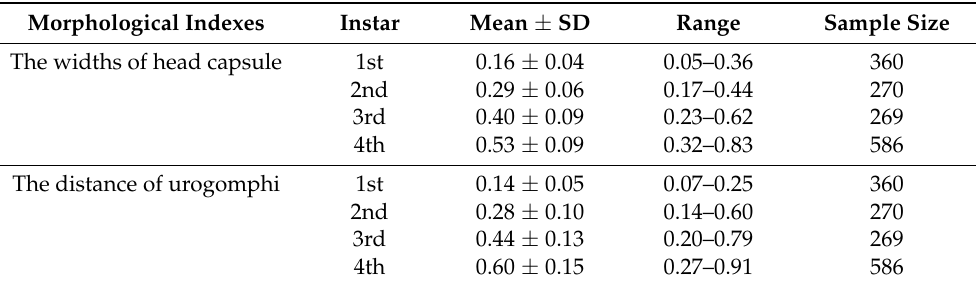
Figure 7. The cluster analysis diagram of head capsule width and cercus spacing at each instar of Necrobia ruficollis larvae under different constant temperatures. There are four instars of Necrobia ruficollis larvae, so the category of cluster analysis was set to four. Through cluster analysis, the larval head capsule width and cercus spacing were divided into four categories. Each blue ellipse represented one instar; (cid:35) Table 5. Means ( ± SD) and range of the widths of head capsule (mm) and the distance of urogomphi (mm) at each instar, obtained by cluster